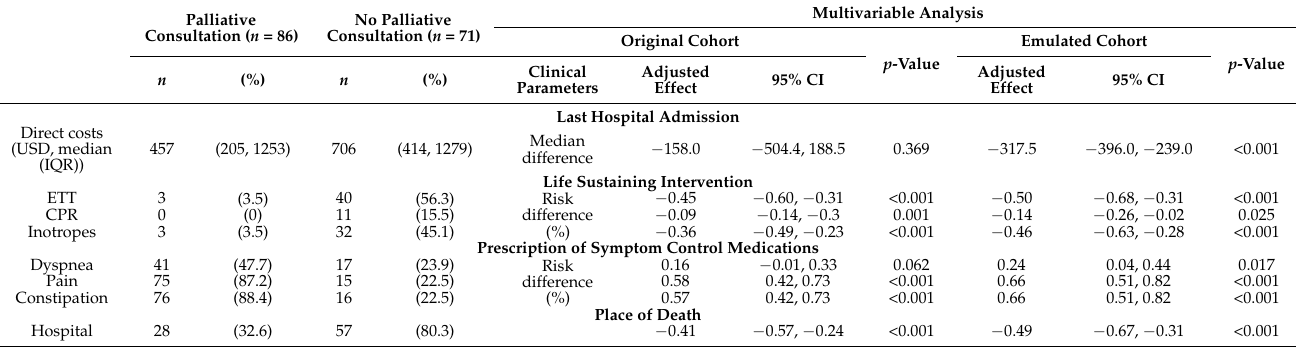
Table 4. Secondary study endpoints in the original cohort and the emulated cohort. 342